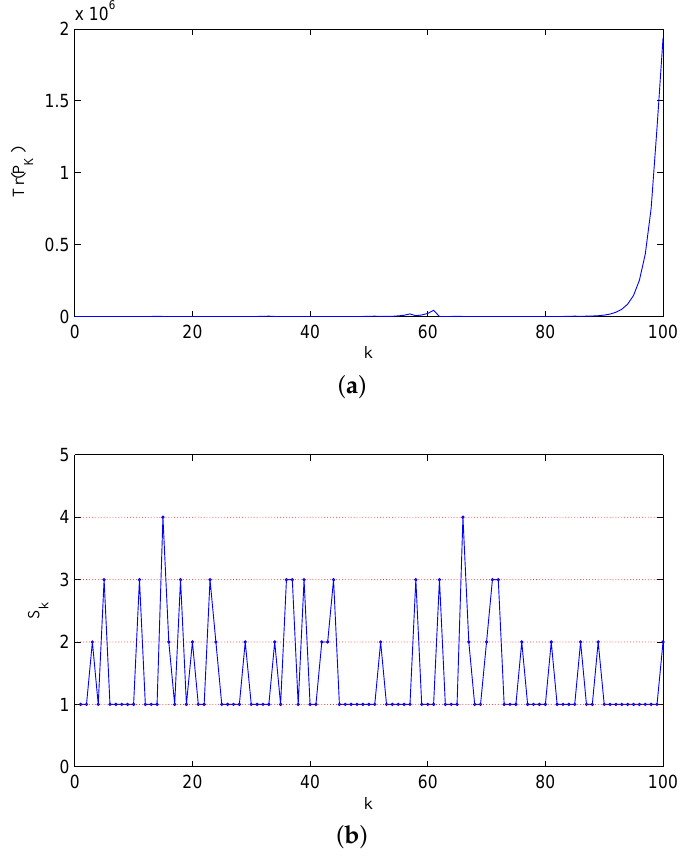
Figure 5. The error covariance matrix P k and channel state S k with ( q 1 , q 2 ) = ( 0.2, 0.2 ) : ( a ) The error covariance; ( b ) the associated channel state.